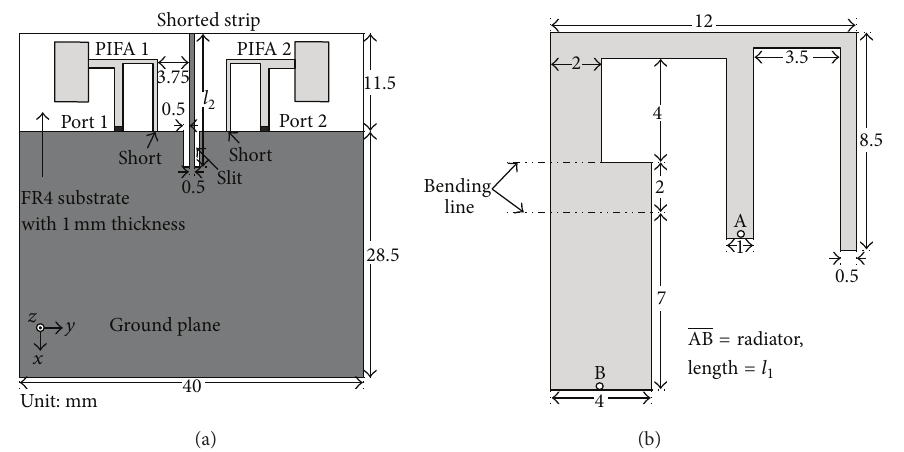
Figure 1: Geometry of the proposed antenna: (a) top view; (b) PIFA.